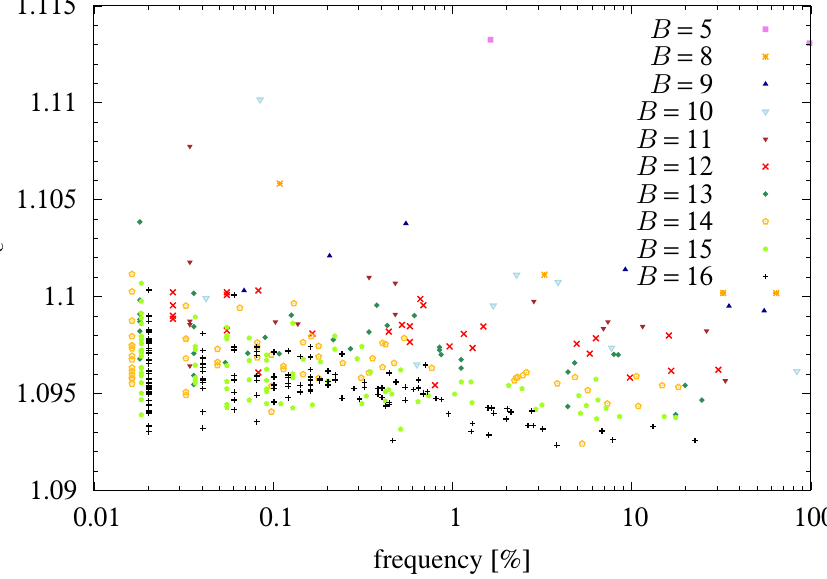
Figure 13. Frequency of a particular solution being found by the pseudo-random